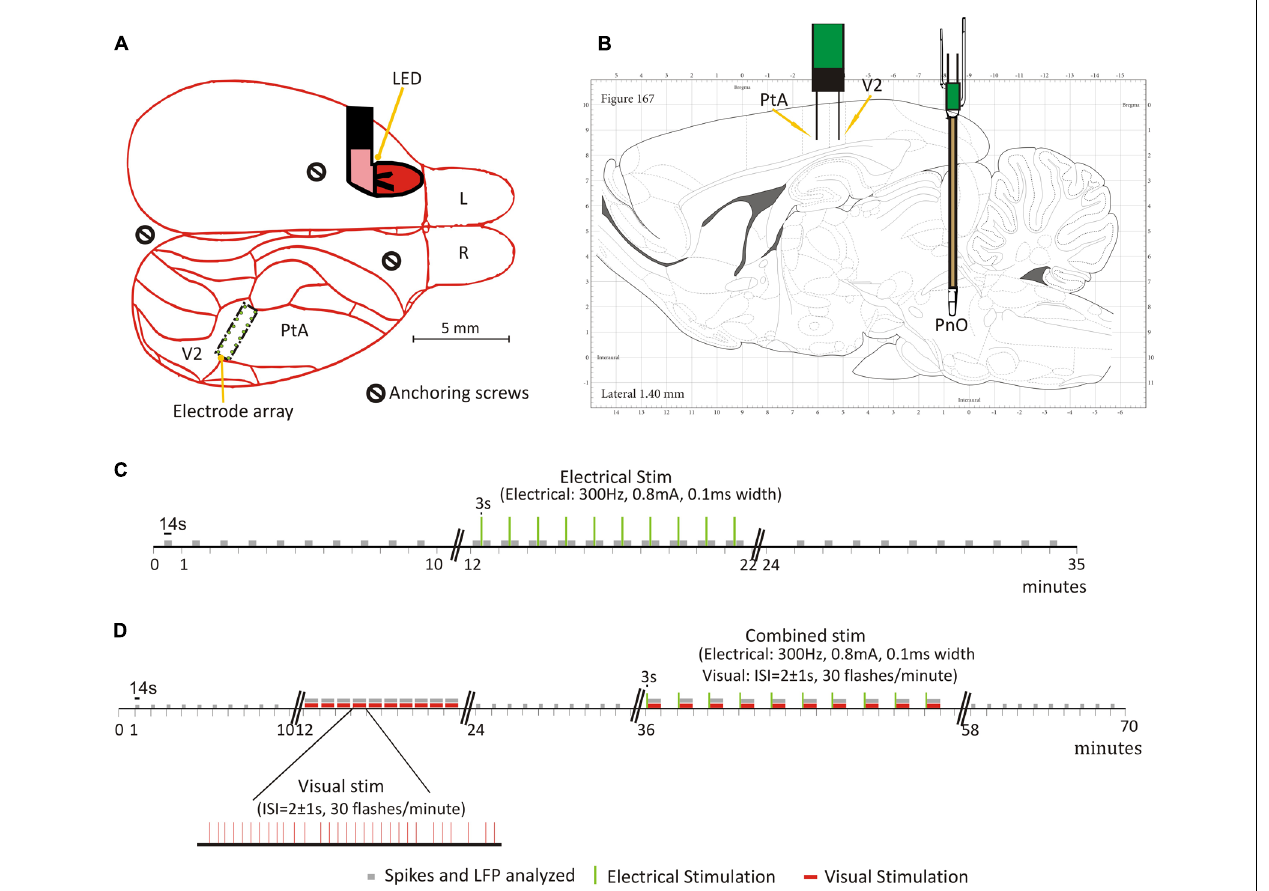
repeated for all desflurane concentrations. Unit activity (UA) and local field potentials (LFPs) were recorded for the duration of the experiment. Electrical stimulation commenced 10 min after steady-state was reached at each desflurane concentration. (D) Testing on day 2. As with day 1, steady-state desflurane was reached at each concentration prior to testing. Light flashes, alone, were delivered 10 min after reaching steady-state desflurane.This was followed by paired stimulation, light flashes presented immediately after PnO stimulation, 10 min later.The desflurane concentration order was randomized on both days of testing. Green vertical lines represent the electrical stimulation. Gray bars represent the segments of data that were used in the analyses. Red bars represent the light